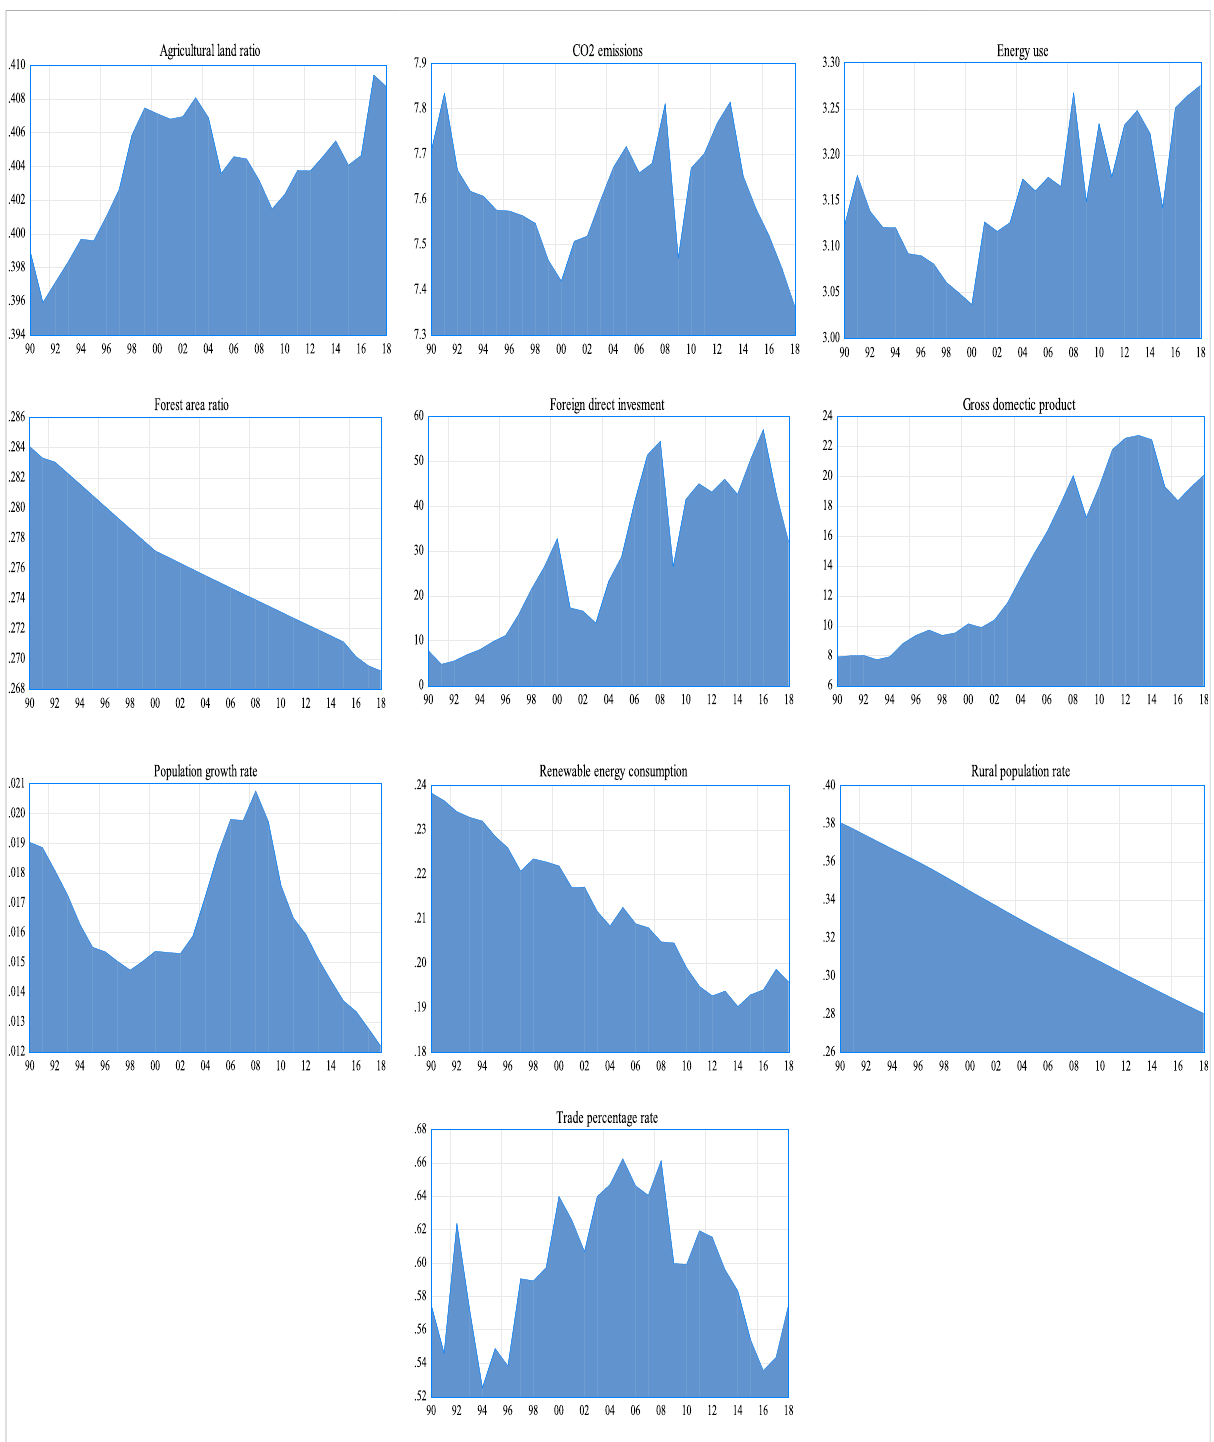
FIGURE 1 Graphicalplotsofstudiedvariables.Notes:Thehorizontalaxisofeachvariableindicatestheyear,e.g.,1990,1991 ...... 2018.Theverticalaxisof each variable denotes the respective raw data, e.g., percentage of total land area in case of agricultural land ratio, metric tons per capita in case of CO2 emissions, kilogram of oil equivalent per capita in case of energy use, and so